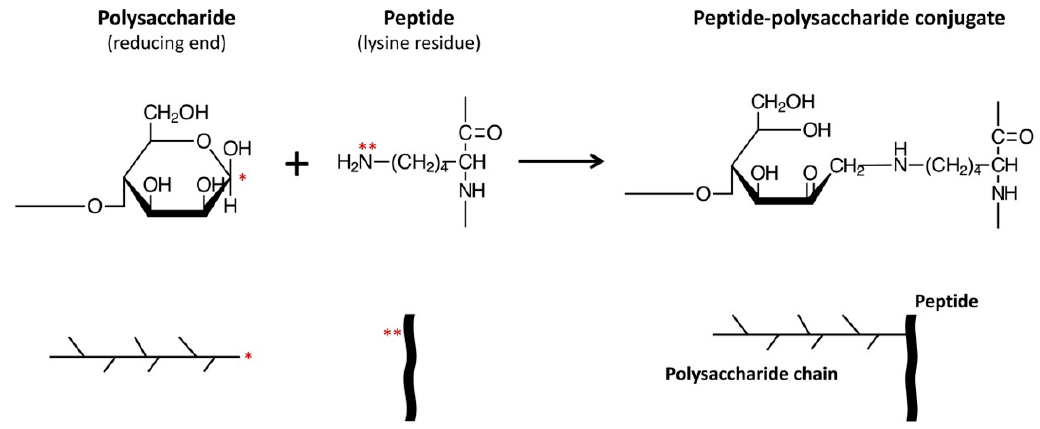
Figure 1. General principle for constructing peptide (e.g., CPP)–polysaccharide (e.g., galactomannan) conjugates using Maillard Reaction [25]. * reducing-end carbonyl group of galactomannan; ** free amino group (e.g., lysine) or N-terminal amino acid.